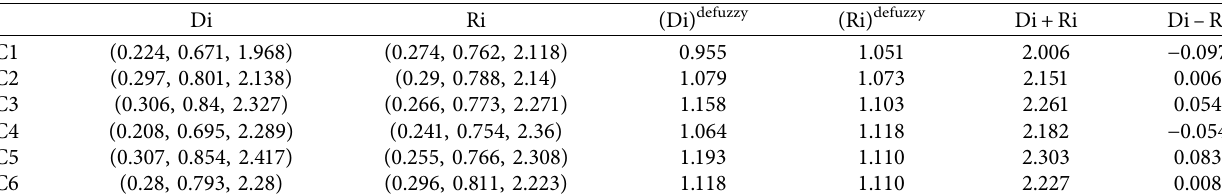
Table 3: Pattern of causal relations of T